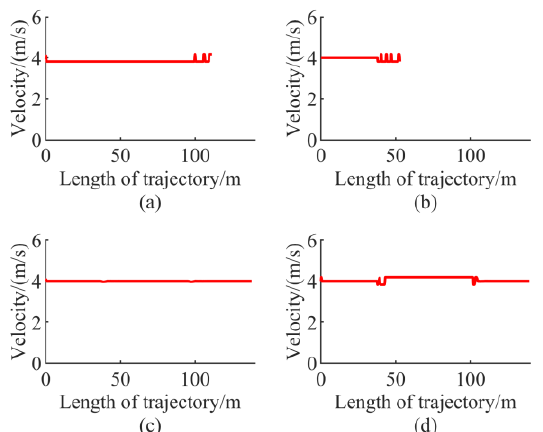
Figure 14. The velocity when velocity is 4 m/s. ( a ) LMPC. ( b ) LEMPC. ( c ) NMPC. ( d ) NEMPC.